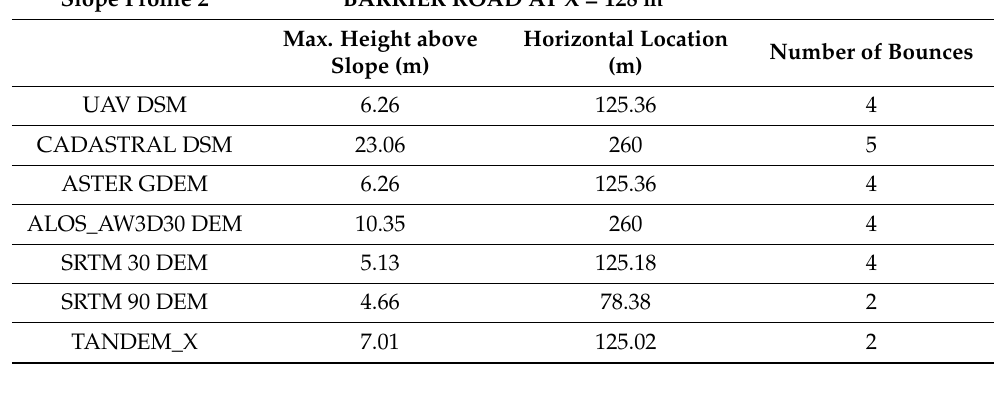
Table 6. Bounce height for the 2nd slope profile.